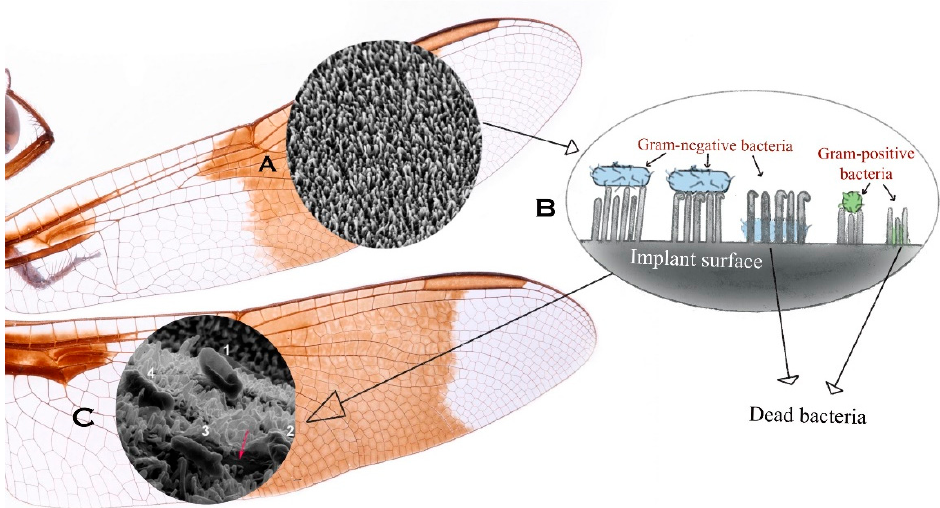
Figure 2. Schematic of dragonfly wings showing: ( A ) representative SEM image of nanopillar structures (magnified 20,000 times); ( B ) antibacterial mechanism of implants modified with dragonfly nanopillars; ( C ) representative SEM image showing nanopillar tearing the bacteria and causing the death of Escherichia coli . Adapted with permission [56].